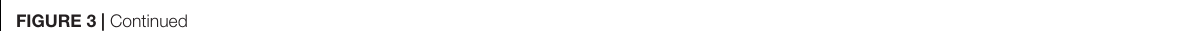
Frontiers in Microbiology |